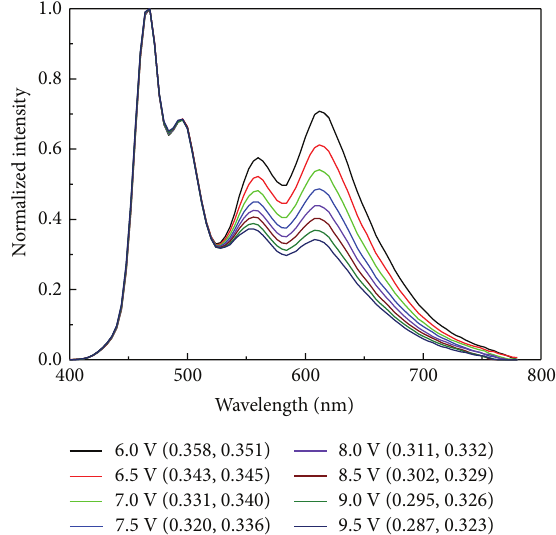
Figure 4: Electroluminescence spectra of the sunlight-style OLED (Device I-3) at various applied voltages.